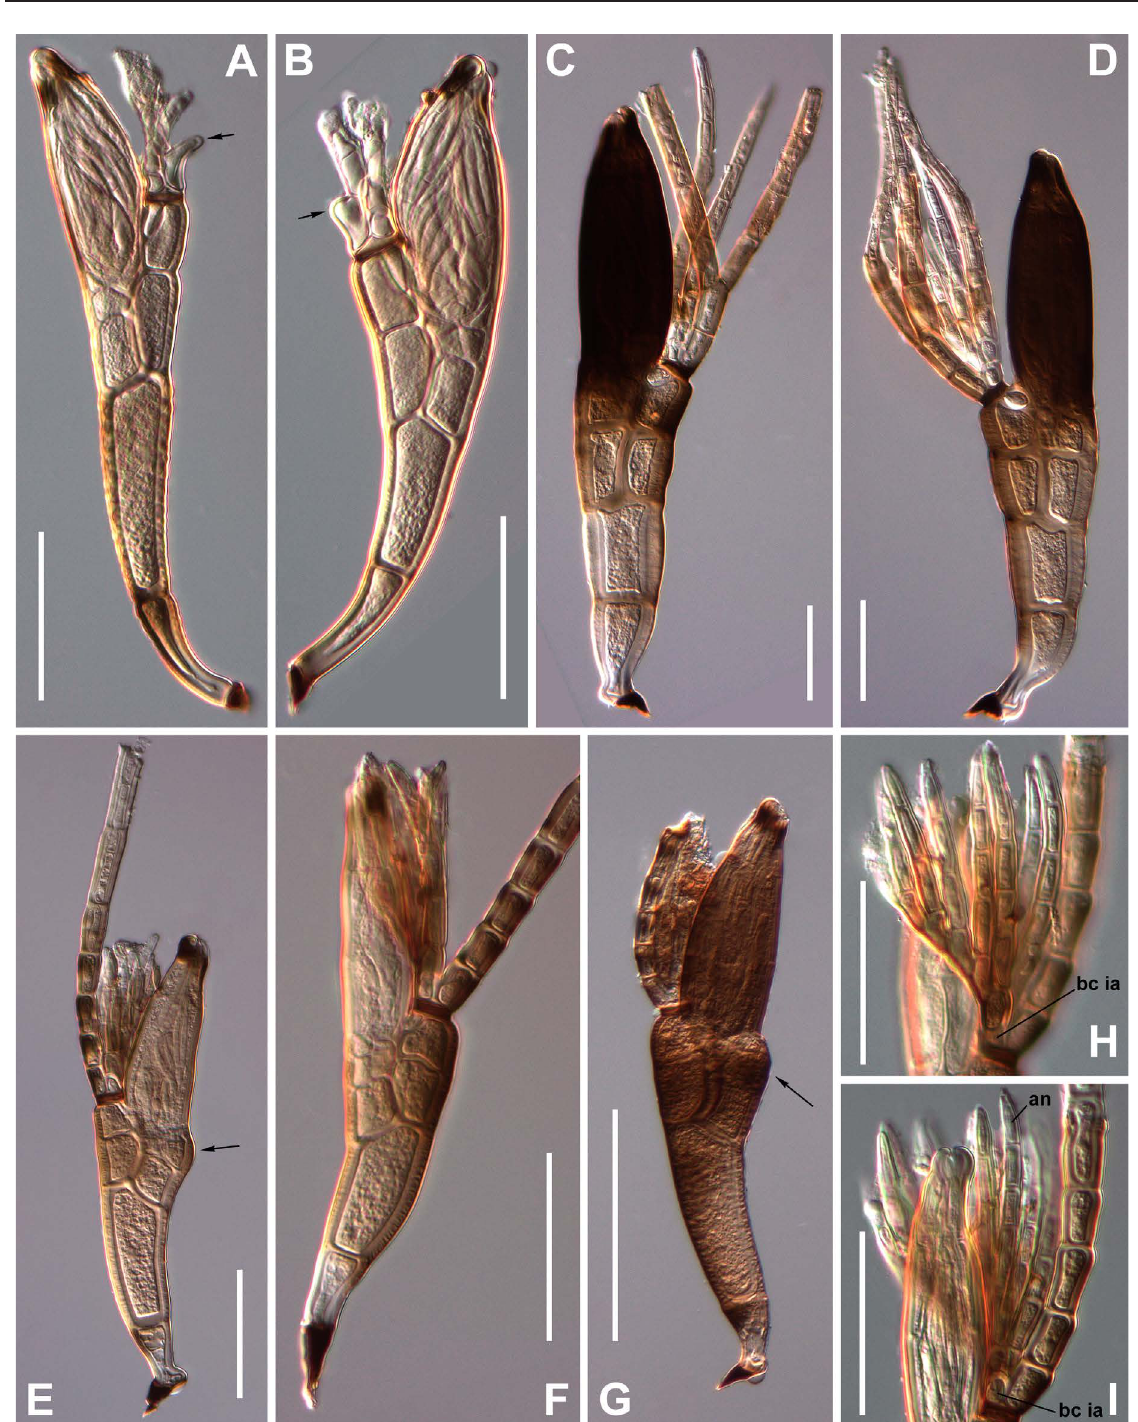
Fig. 37. Laboulbenia spp. A – B . L. manubriolata Thaxt. Mature thalli with labelled outgrowth on basal cell of outer appendage (arrows). – C – D . L. melanaria Thaxt. Mature thalli. – E – I . L. metableti Scheloske. E – G . Mature thalli with protuberant cell VII labelled with arrows in E and G. H – I . Inner appendage in detail with two focus levels, near in H, far in I; “bc ia” is the basal cell of inner appendage, “an” is an antheridium. Scale bars: 50 µm. Photographs from slides ZMUC C-F-122604 (A–B), ZMUC C-F-124124 (C–D), ZMUC C-F-123103 (E), ZMUC C-F-123072 (F), ZMUC C-F-123384 (G), ZMUC C-F-122626